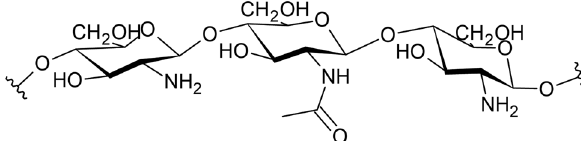
Figure 3: Structure of